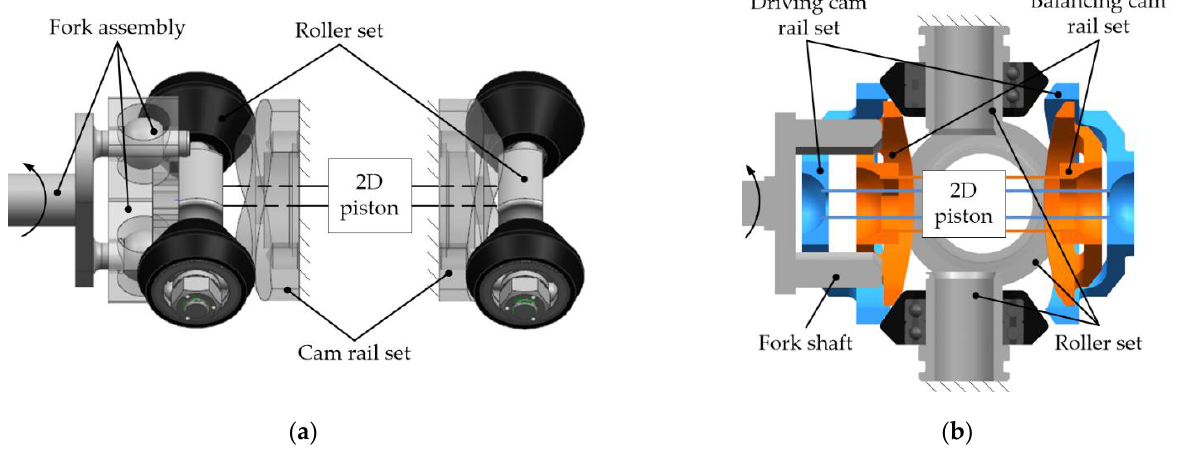
Figure 1. Schematic diagram of the 2D transmission mechanism: ( a ) the overall architecture of the 2D transmission mechanism; ( b ) the 2D transmission mechanism with inertial force balanced.